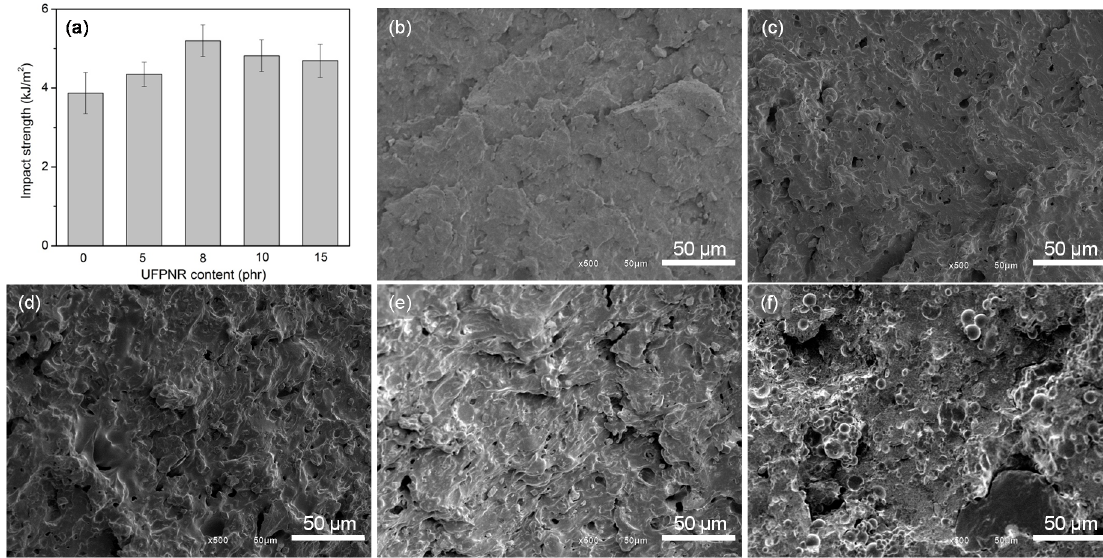
Figure 7. Impact strength of PVC prepared with different contents of UFPNR ( a ), and SEM micrographs of surface fracture of PVC prepared with 0 ( b ), 5 ( c ), 8 ( d ), 10 ( e ), and 15 ( f ) phr UFPNR.